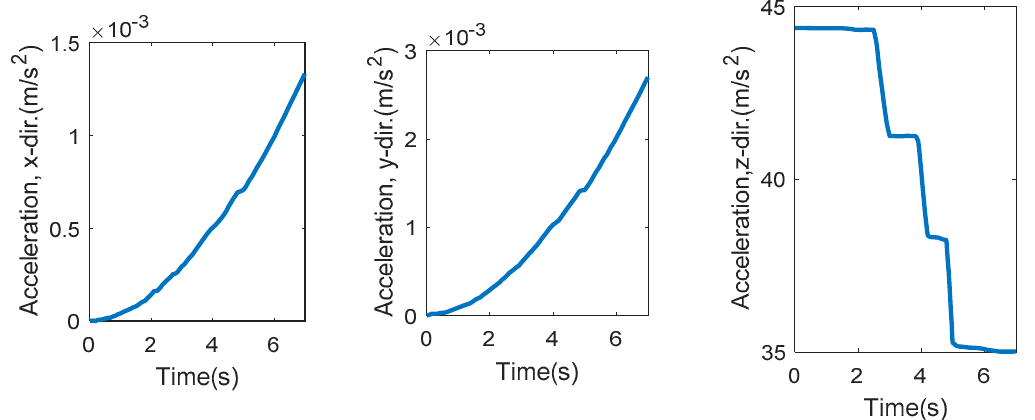
Figure 13. Variations in linear acceleration in the robustness scenario.